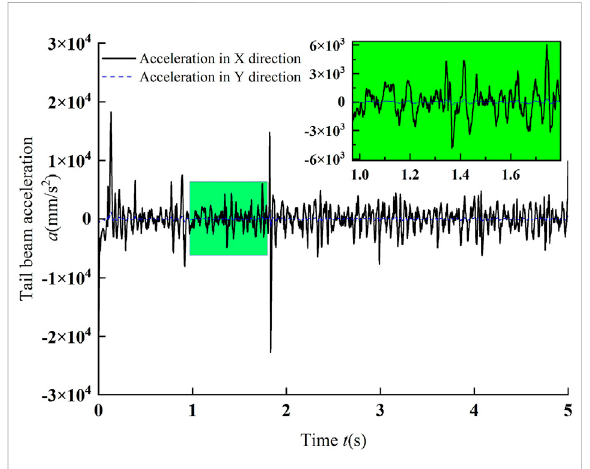
FIGURE 11 Time-domain diagram of tail beam vibration with 20 mm particle size.